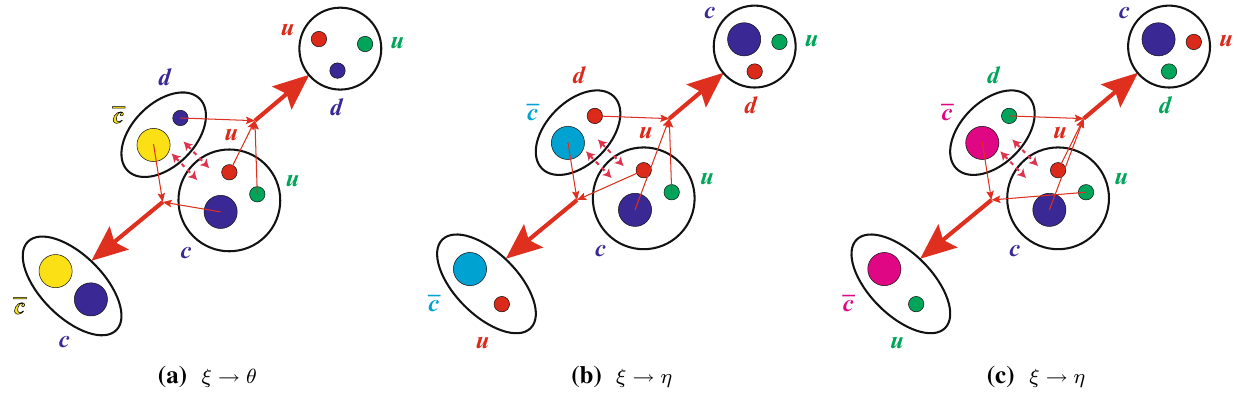
Fig. 3 Fall-apart decays of P c states as ¯ D ( ∗ ) − Σ ++ c molecular states, investigated through the ξ( x , y ) currents. There are three possibilities: a ξ → θ , b ξ → η , and c again ξ → η . Their probabilities are the same (33%), if only considering the color degree of